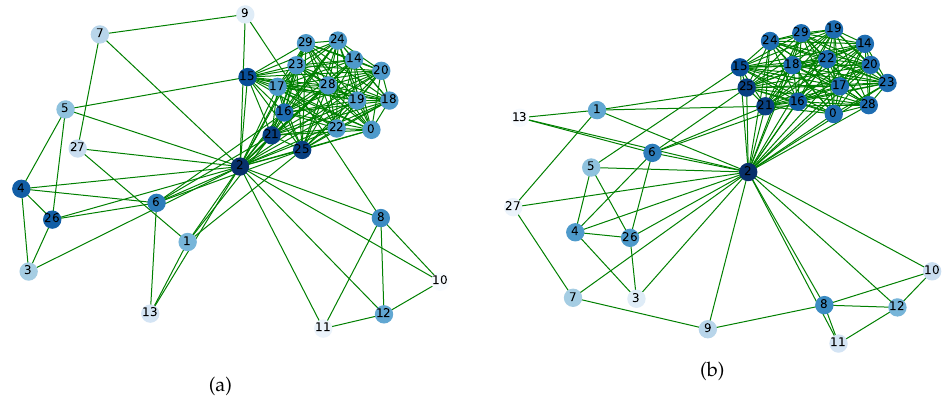
Figure 4. The score of the graph node after improved self-attention GNN training is indicated in each node by colour shade. ( a ) Two-category classification for students whose ID number is 61465 and exam score is 91.28; ( b ) Three-category classification for student whose ID number is 61465 and exam score is